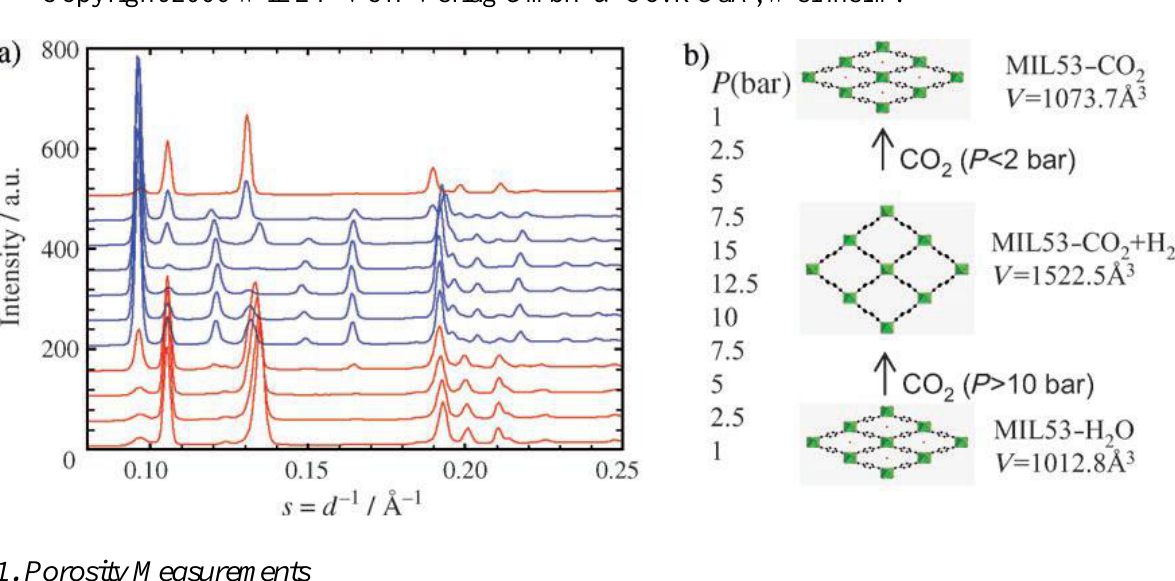
; ( b ) Schematic diagram of 2